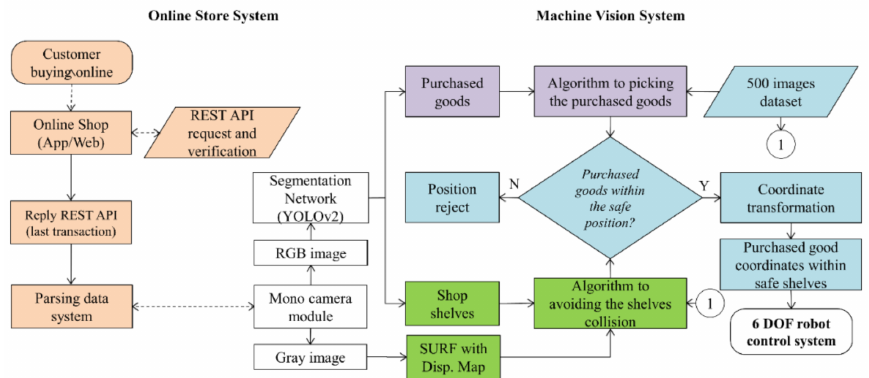
Figure 1. Overall architecture diagram of the AIoT based picking